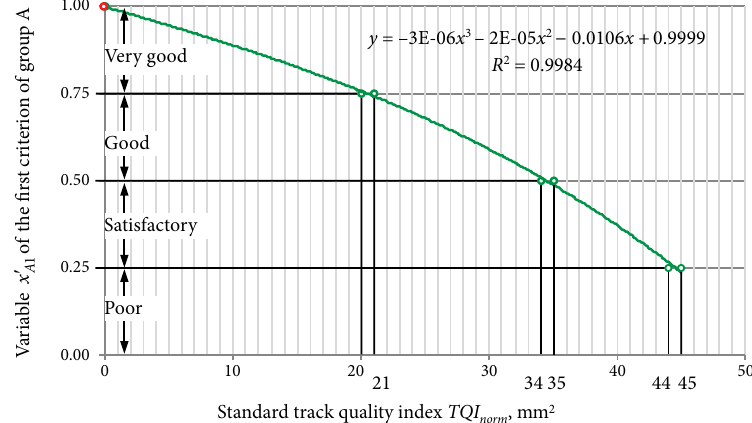
norm values, and asymptoti- norm values (solid mod ), quadratic ( y ), 1 2